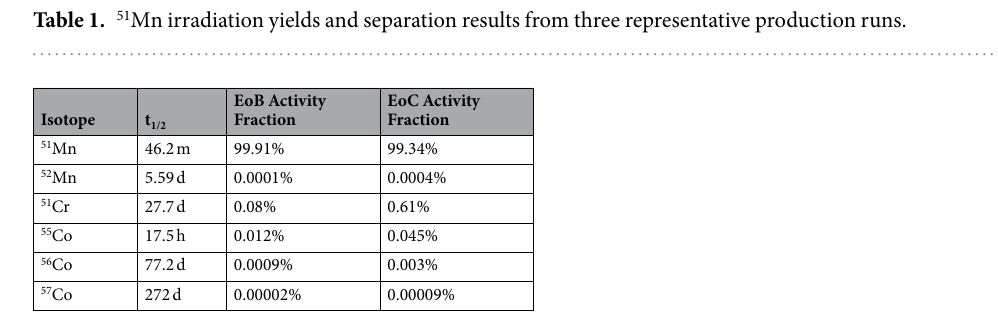
Table 2. Radionuclidic purity of separated 51 Mn product measured by HPGe gamma